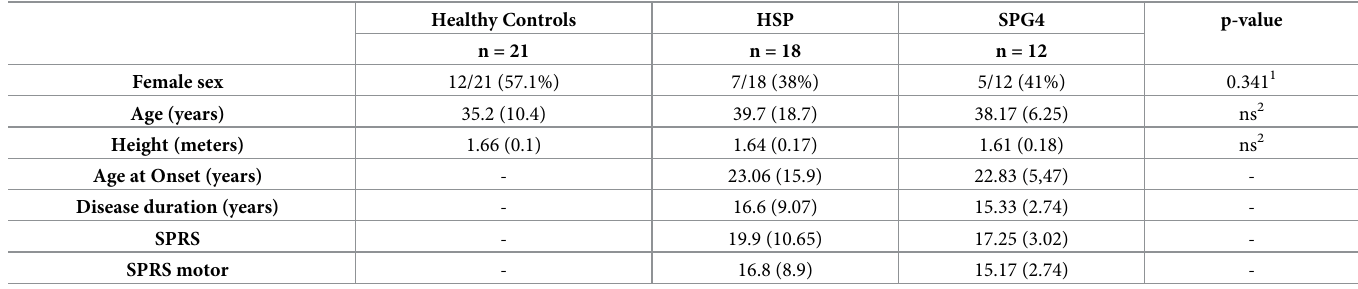
Table 1. Main demographics characteristics of the study sample.